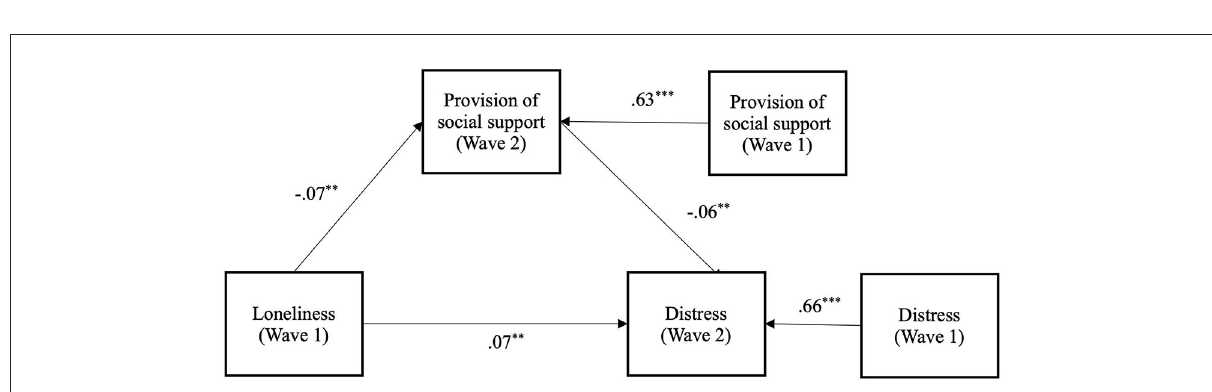
FIGURE5 Longitudinal mediation model of the effect of loneliness at wave 1 on psychological distress at wave 2, via provision of social support at wave 2, while controlling for wave 1 levels of distress and provision of social (** p < 0.01. *** p <